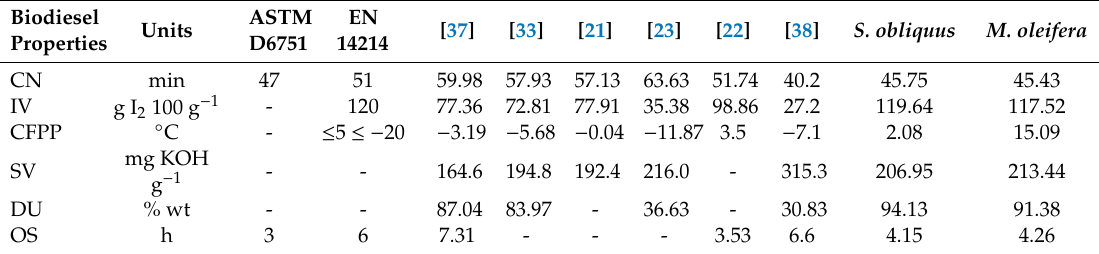
Table 9. The physico-chemical properties of Scenedesmus obliquus base biodiesel production compared with international standards and those in other